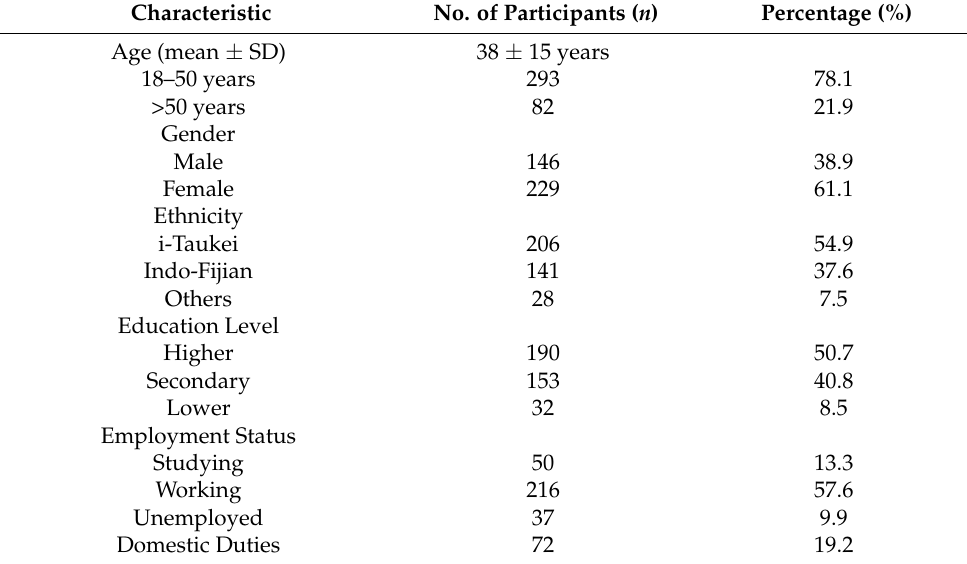
Table 1. Sociodemographic characteristics of participants ( n =